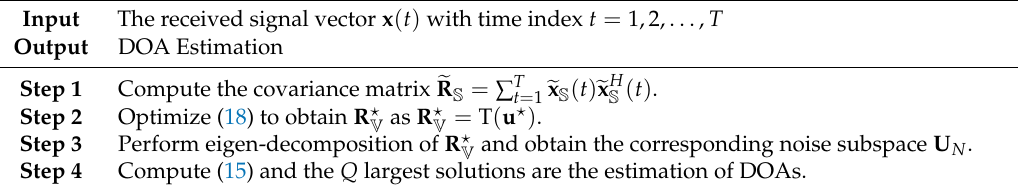
Table 1. Direct approach for coarray interpolation. DOA: direction of